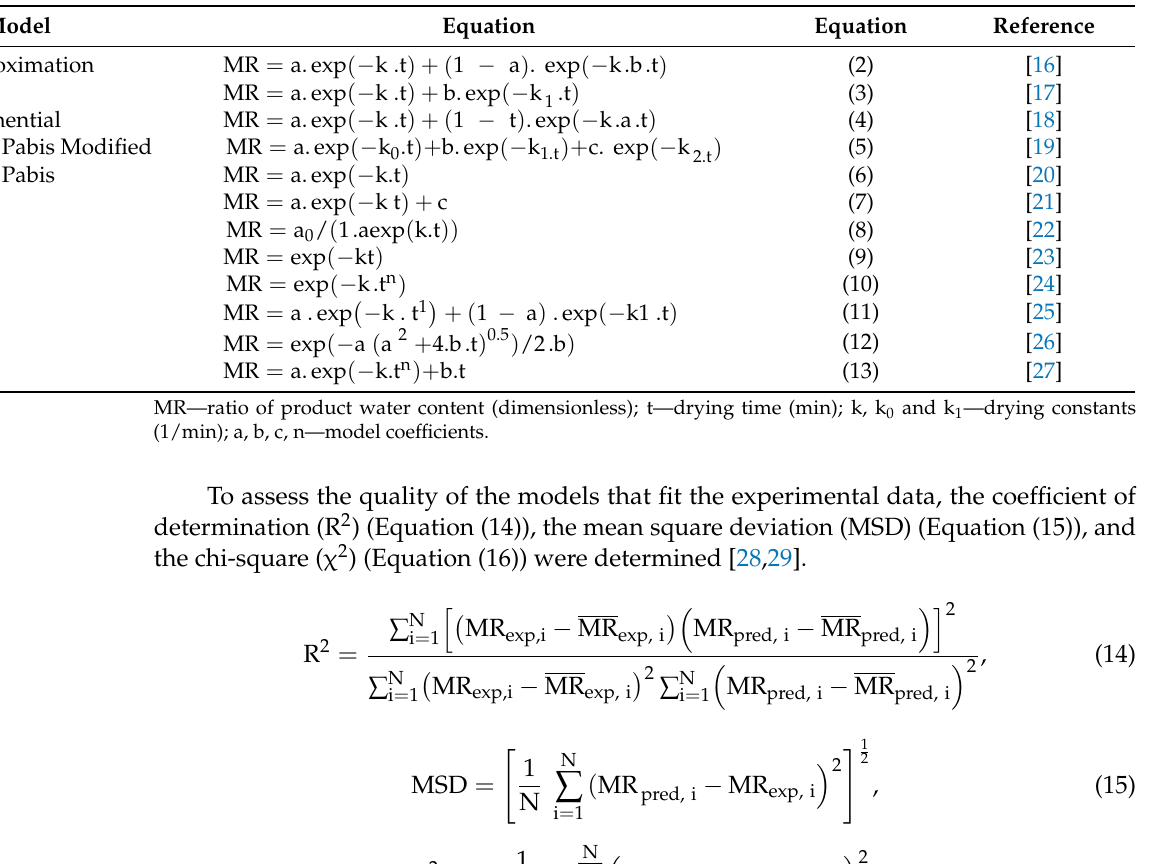
Table 1. Mathematical models adjusted to drying kinetics